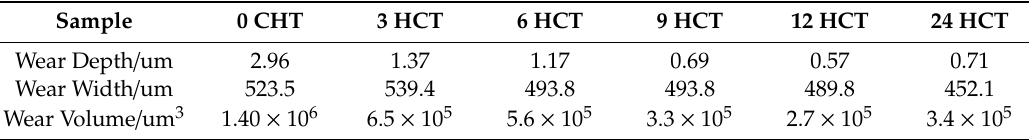
Table 3. Wear depth, width and volume of wear scars.